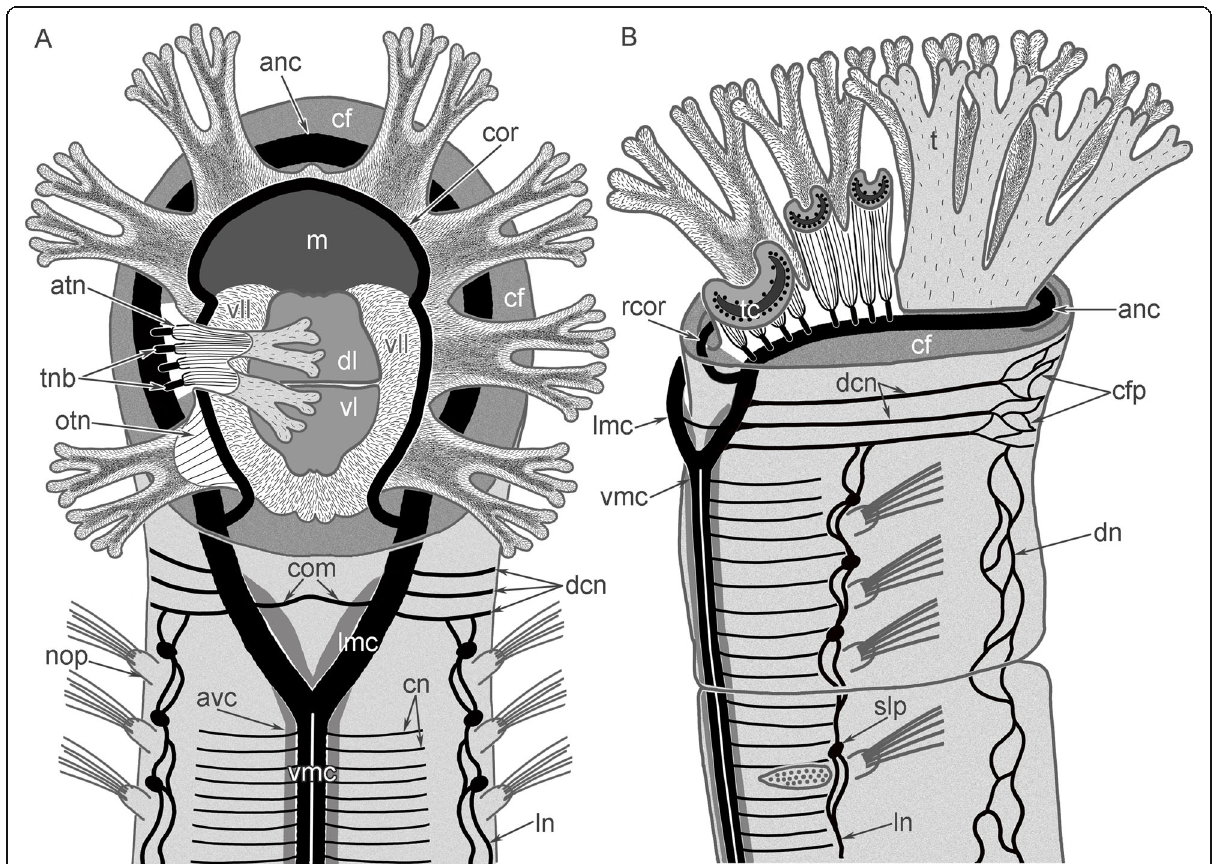
Fig. 8 Schemes of the nervous system organization of the anterior body part of Owenia borealis . All nerve elements are shown in black. A Ventral view. B Lateral view. Abbreviations: anc – outer ring of the anterior nerve center; atn – aboral tentacle nerves; avc – peripheral zone of the ventral medullary cord; cf. – collar fold; cfp – collar fold dorsal nerve plexus; cn – cross nerve; com – ventral commissure; cor – inner (= circumoral) nerve ring of the anterior nerve center; dcn – dorsal cross nerve; dl – dorsal lip of the ventral pharyngeal organ; dn – dorsal neurites; ln – lateral nerve; lmc – lateral medullary cord; m – mouth; nep – neuropodia; nop – notopodia; otn – oral tentacle nerves; pbr – posterior portion of the brain; ph – pharynx; rcor – root of circumoral nerve ring; slp – serotonin-like immunoreactive perikarya; t – tentacle; tbn – tentacle neurite bundle; tc – tentacle coelomic cavity; vl – ventral lip of the ventral pharyngeal organ; vmc – ventral medullary